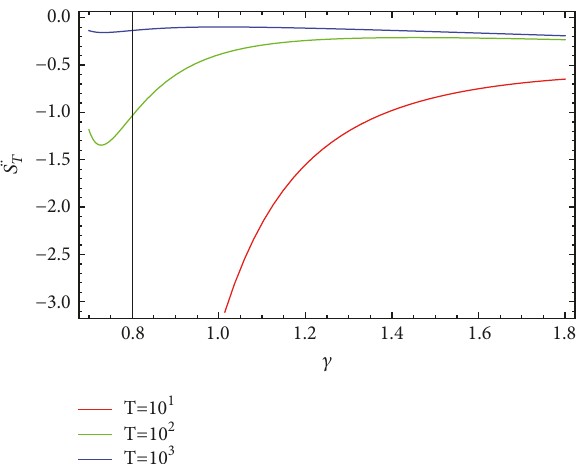
̈𝑆 𝛾 for power law correction when Γ is Figure 7: Plot of 𝑇 versus